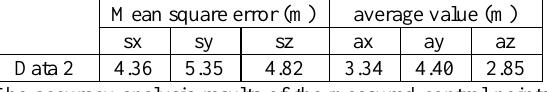
Table 3: Adjustment accuracy analysis with 191 GCPs in